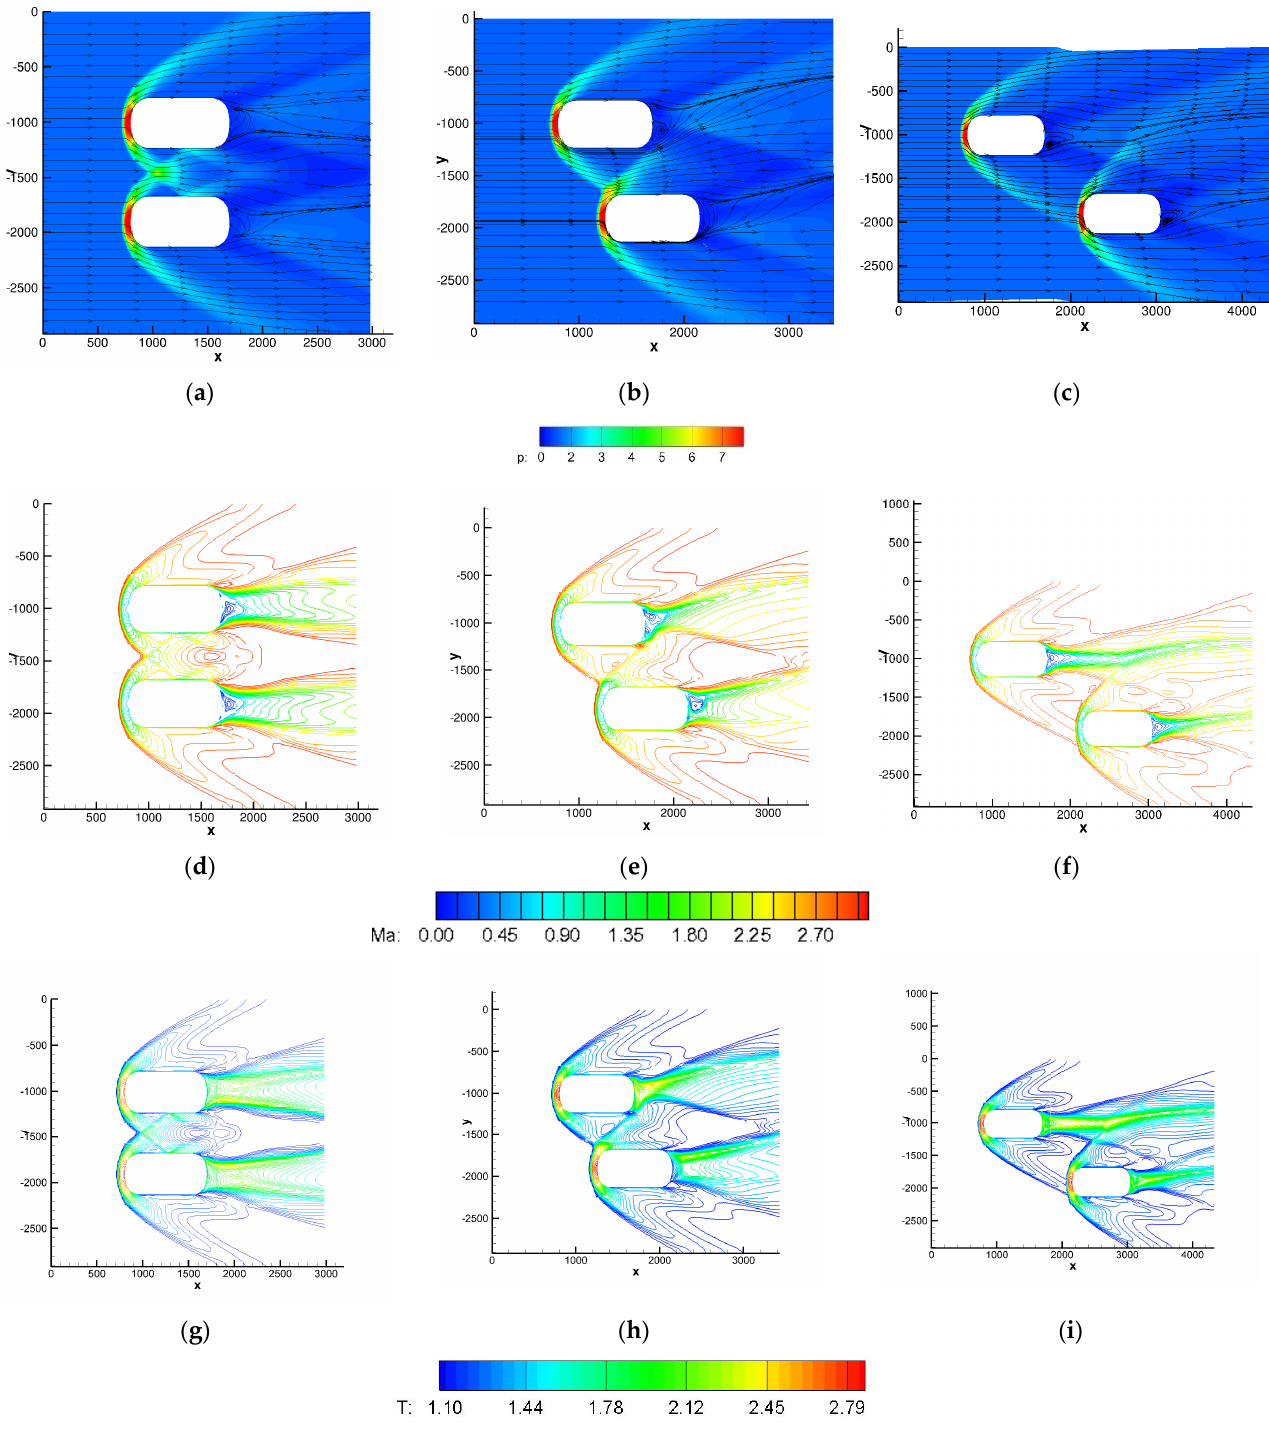
Figure 12. Pressure, streamline distribution, Mach number and temperature contours when propul- sion bottles are placed at different position: ( a ) Δ x = 0; ( b ) Δ x = D; ( c ) Δ x = 3D; ( d ) Δ x = 0; ( e ) Δ x = D; ( f ) Δ x = 3D; ( g ) Δ x = 0; ( h ) Δ x = D; ( i ) Δ x = 3D.